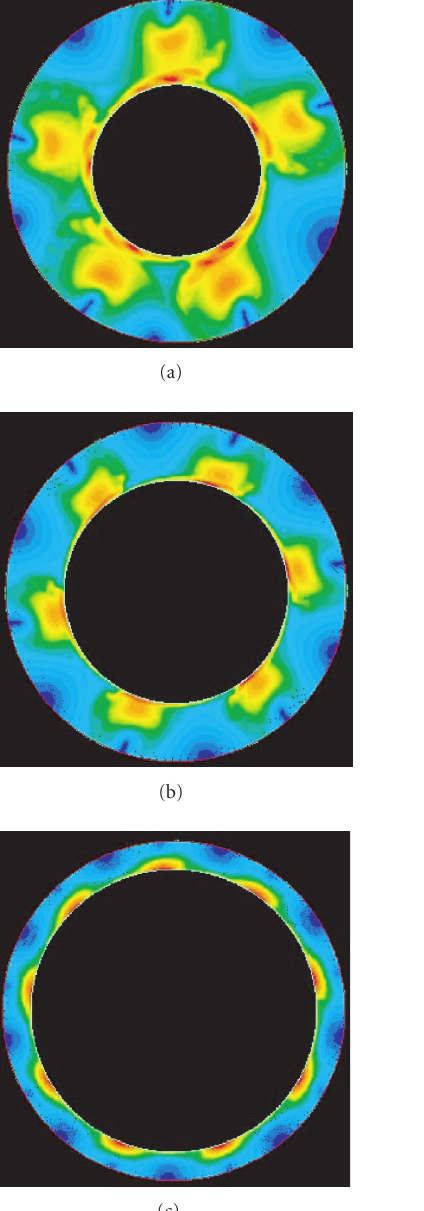
Figure 6: Solutions of the rotating instability for (a) r 3 /r 2 = 2, (b) /r r = 1 . 52, and (c) r 3 2